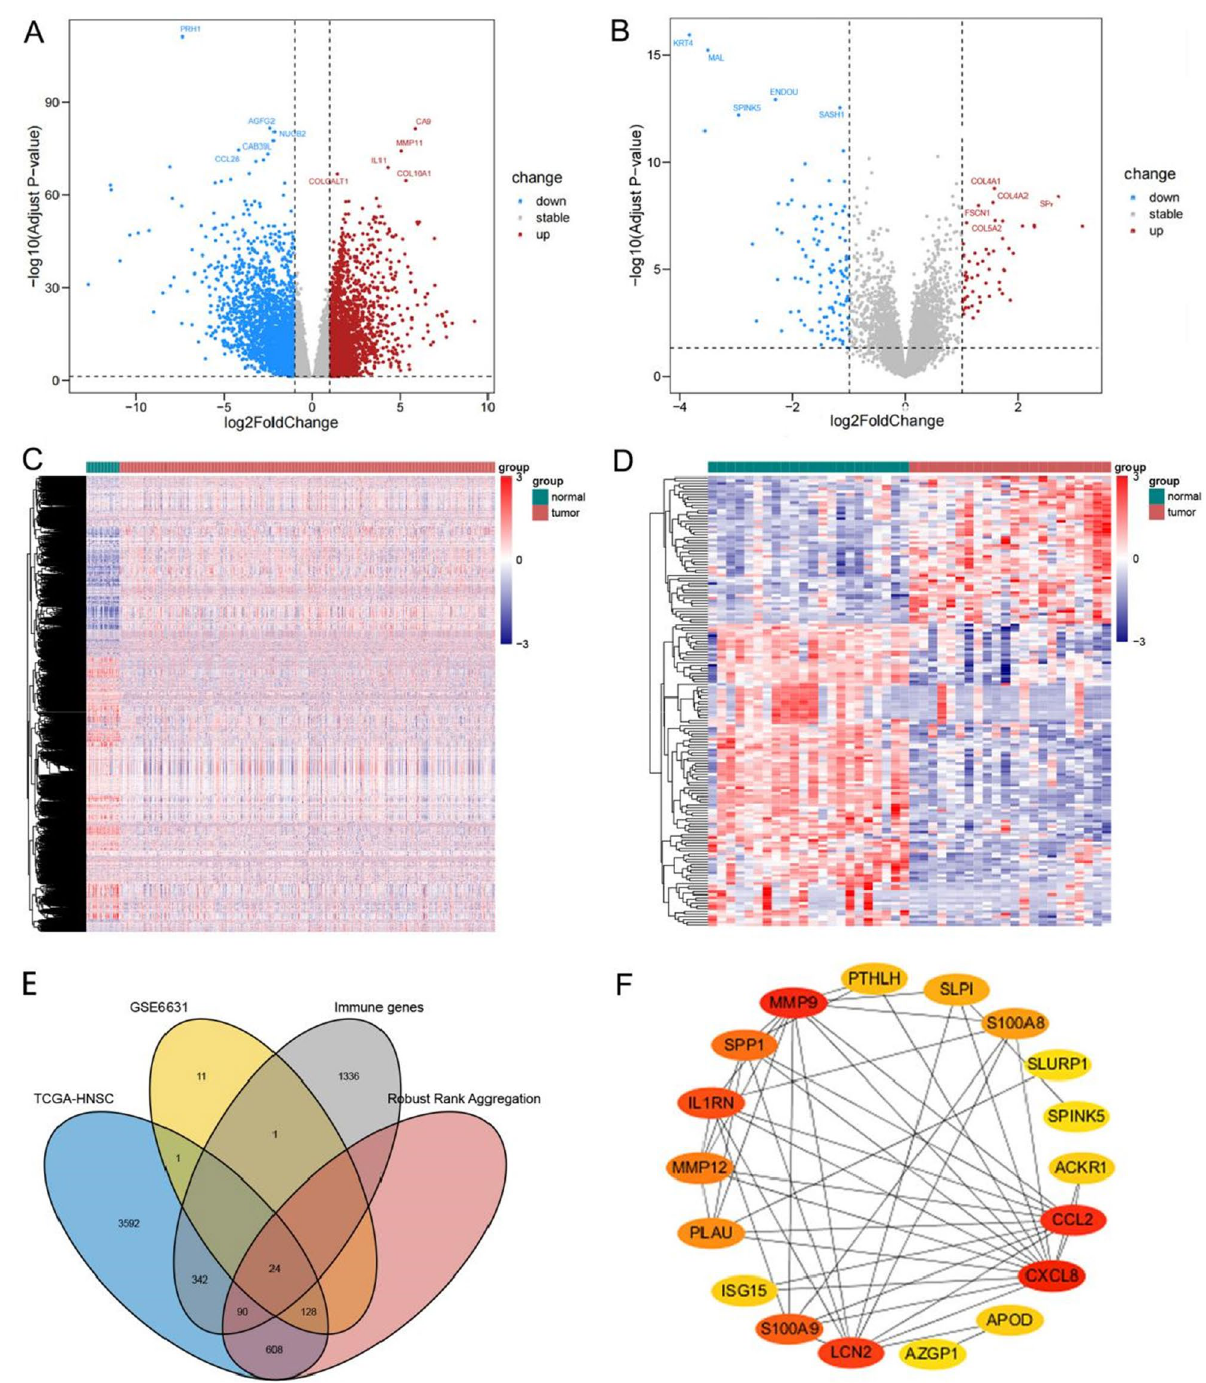
Figure 2. Assessment of differentially expressed genes (DEGs) in our analysis. ( A , B ) Volcano plots showing DEGs in TCGA-HNSC and GSE6631 (|log2 (Fold Change)| > 1, adjust p-value < 0.05); blue dots: significantly down-regulated; red dots: significantly up-regulated; grey dots: no significant differences; the top 10 significant genes are denoted. ( C , D ) Heatmaps showing DEGs of TCGA-HNSC and GSE6631. ( E ) Venn diagram showing detail information about overlaps of DEGs across four datasets. ( F ) The hub immune-related genes (IRGs) in our